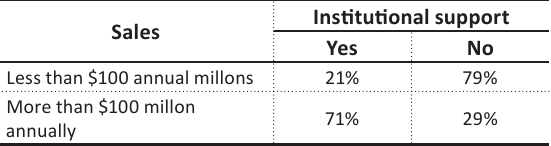
Table 2. Contingency matrix between sales and institutional